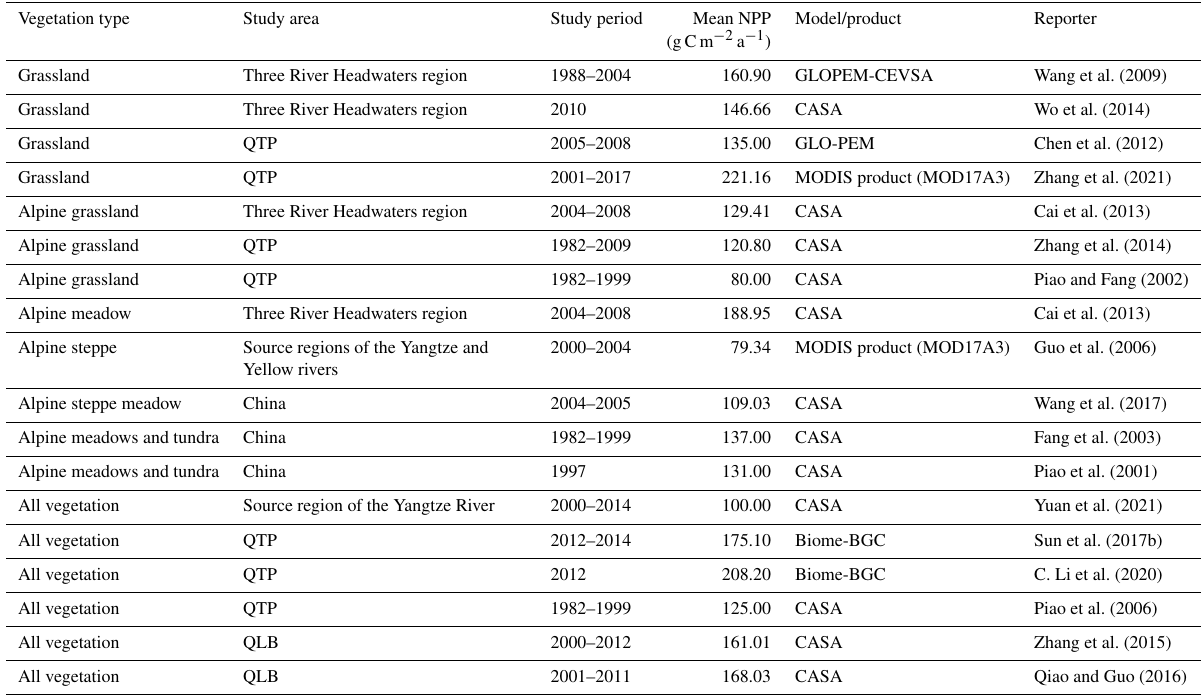
Table 5. Published versus simulated